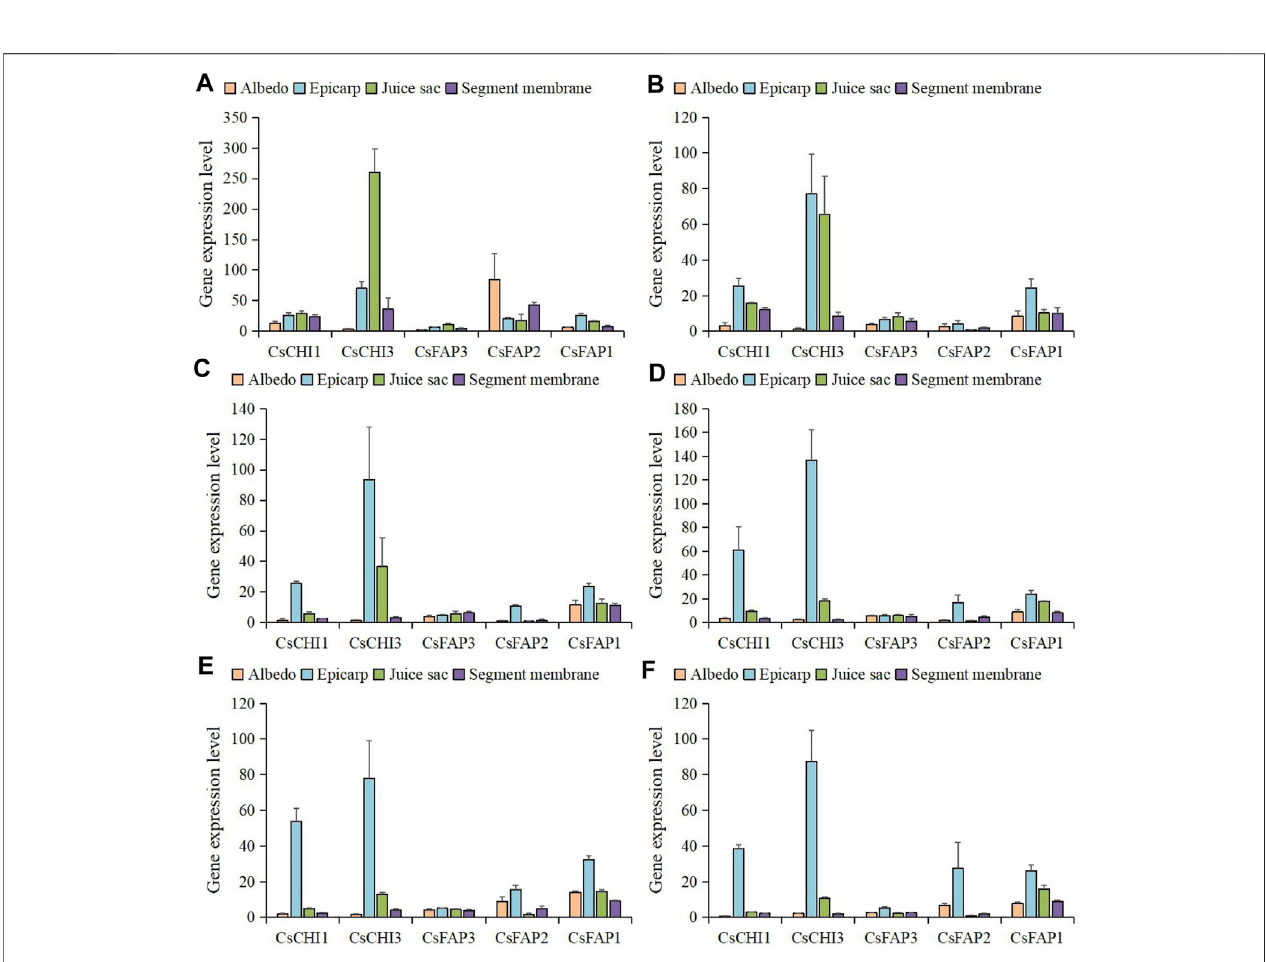
FIGURE6 | Expressionlevel of CHI genesin albedo, epicarp,juice sac, and segment membrane. (A – F) shows theexpression patterns of CHI genesat the 50, 80, 120, 155, 180, and 220 DAF stages.